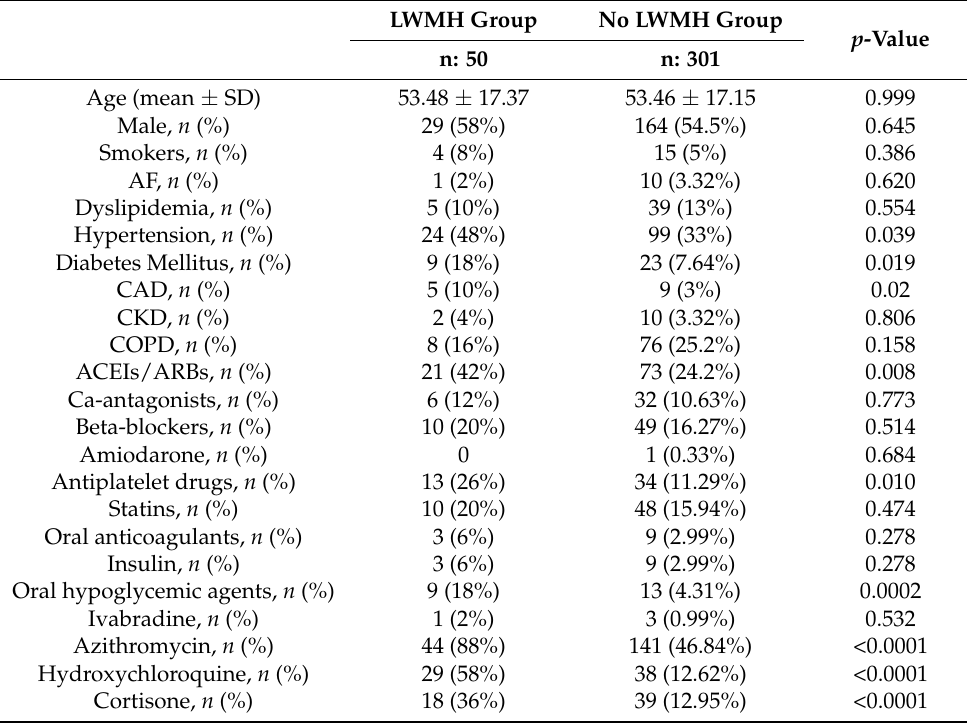
Table 4. Clinical features of COVID-19 patients with and without low molecular weight heparin